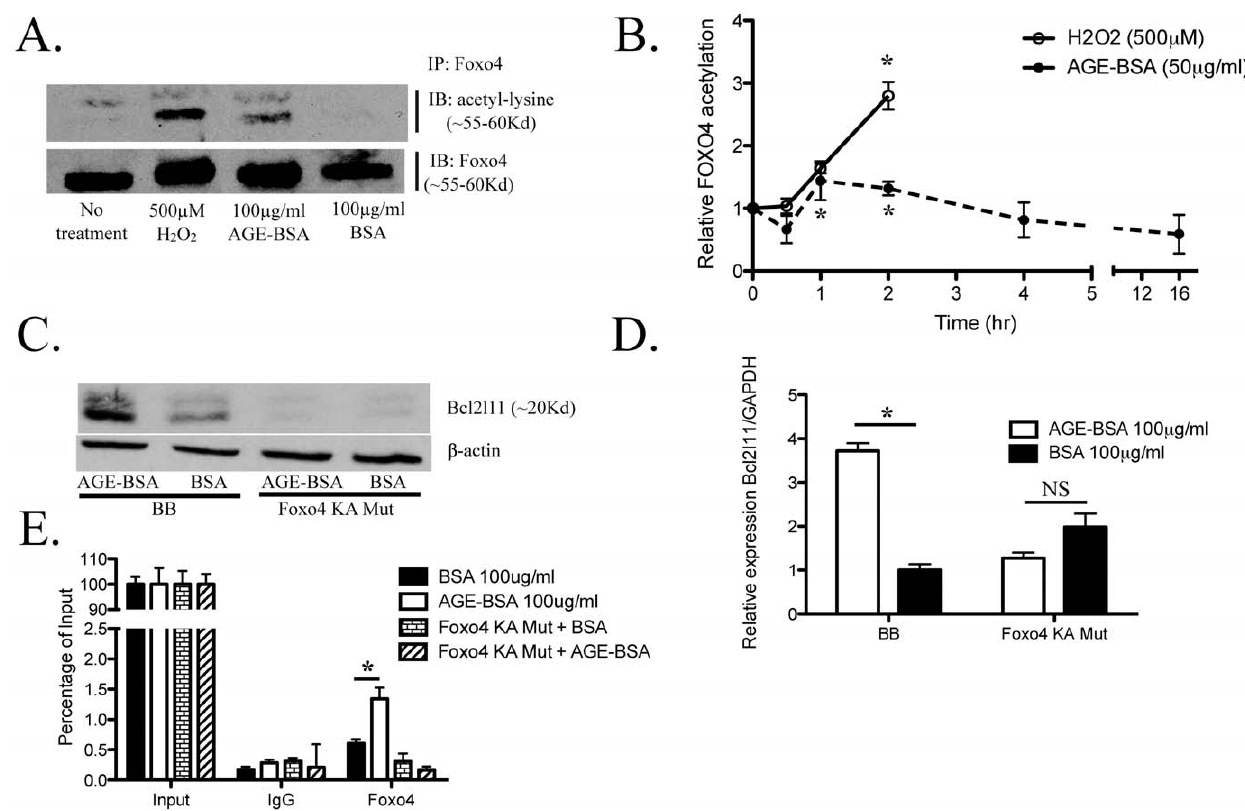
Figure 2. Acetylation of Foxo4 is required for AGE-BSA-induced Bcl2l11 acetylation. (A) Acetylation of endogenous Foxo4 in cultured podocytes treated with 500 m M of H 2 O 2 , 100 m g/ml of AGE-BSA or 100 m g/ml of BSA for 2 h was assessed by gel electrophoresis of immunoprecipitating Foxo4, followed by immunoblotted with an anti-acetyl-lysine antibody to detect acetylated Foxo4. Immunoblotting with an anti-Foxo4 antibody confirms the immunoprecipitation of Foxo4. (B) H 2 O 2 - and AGE-BSA-induced acetylation of a FLAG-Foxo4 fusion protein was confirmed using a fluorescence-based in vitro acetylation assay. 293 cells transfected with a FLAG-Foxo4 fusion construct and serum starved for 16– 18 hrs were treated with either H 2 O 2 (500 m M) or AGE-BSA (50 m g/ml) at 0, 0.5, 1, 2, 4, or 16 hr. (Relative Foxo4 acetylation with AGE-BSA at 1 h is 1.36 6 0.12 and at 2 h is 1.32 6 0.11, *p , 0.05, n=4; with 500 m M of H 2 O 2 at 2 hr is 2.80 6 0.22 *p , 0.05, n=3). The expression of Bcl2l11 in podocytes with stable over expression of the Foxo4 KA mutant (Foxo4 KA Mut) was compared to control podocytes (BB) after AGE-BSA (100 m g/ml) treatment for either 24 h (in RT PCR experiments) or 72 h (for Western Blotting experiments). Foxo4 KA Mut over expression abrogated AGE-BSA induced Bcl2l11 expression as characterized by Western blotting (C) and RT PCR (D). Binding of Foxo4 to the FBE in the Bcl2l11 promoter was reduced in podocytes with Foxo4 KA Mut over expression as characterized by ChIP of Foxo4 followed by RTPCR using primers flanking FBE (FBE for and FBE rev ).